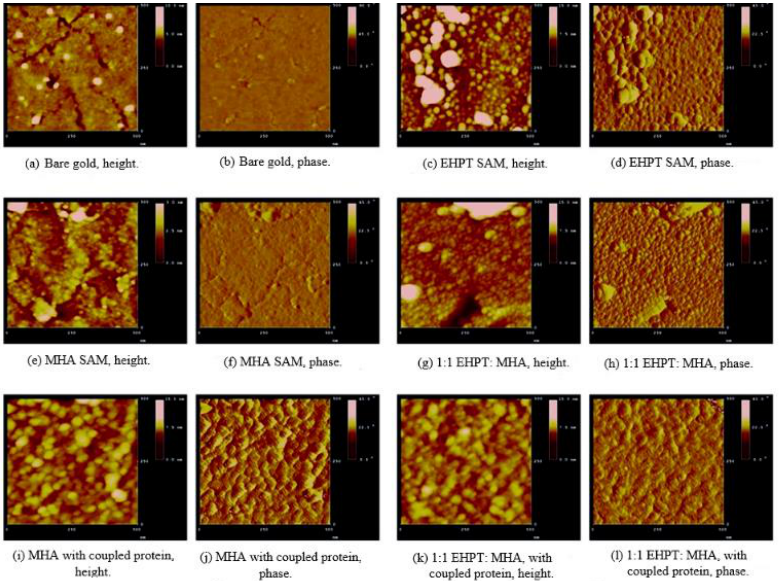
Figure 2. Atomic force microscopy of pure and mixed EHPT and MHA SAMs on template-stripped Au (111). All images were acquired in tapping mode with a scan speed of 1 Hz. ( a , b ) Bare gold. Wide and flat terraces with smaller subgrains are seen; the tall specks are presumed to be dust particles adsorbed to the surface. ( c , d ) EHPT SAM. The underlying terraces are concealed by this thick, granular film. ( e , f ) MHA SAM. This tightly packed thin organic monolayer essentially mirrors the underlying terrace structure. ( g , h ) Mixed 1:1 EHPT:MHA SAM. This strongly resembles an EHPT SAM, with polymer granules seen across the entire surface. Despite the EHPT, the underlying gold is not entirely effaced. ( i , j ) MHA SAM after IgG coupling. Large globular protein molecules (likely including small aggregates) cover the surface. ( k , l ) Mixed 1:1 EHPT:MHA SAM after protein coupling. The surface now matches the MHA/protein image, showing the same irregularly globular structures [44].